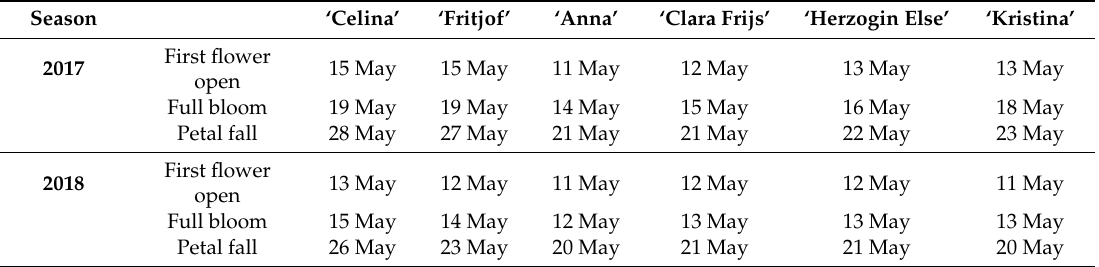
Table 2. Dates of first bloom, full bloom (80% of flowers open), and end of flowering (80% of petals fallen) for ‘Celina’ and five pollinizer pear cultivars in Ullensvang, Norway, in 2017 and 2018. Season ‘Celina’ ‘Fritjof’ ‘Anna’ ‘Clara Frijs’ ‘Herzogin Else’